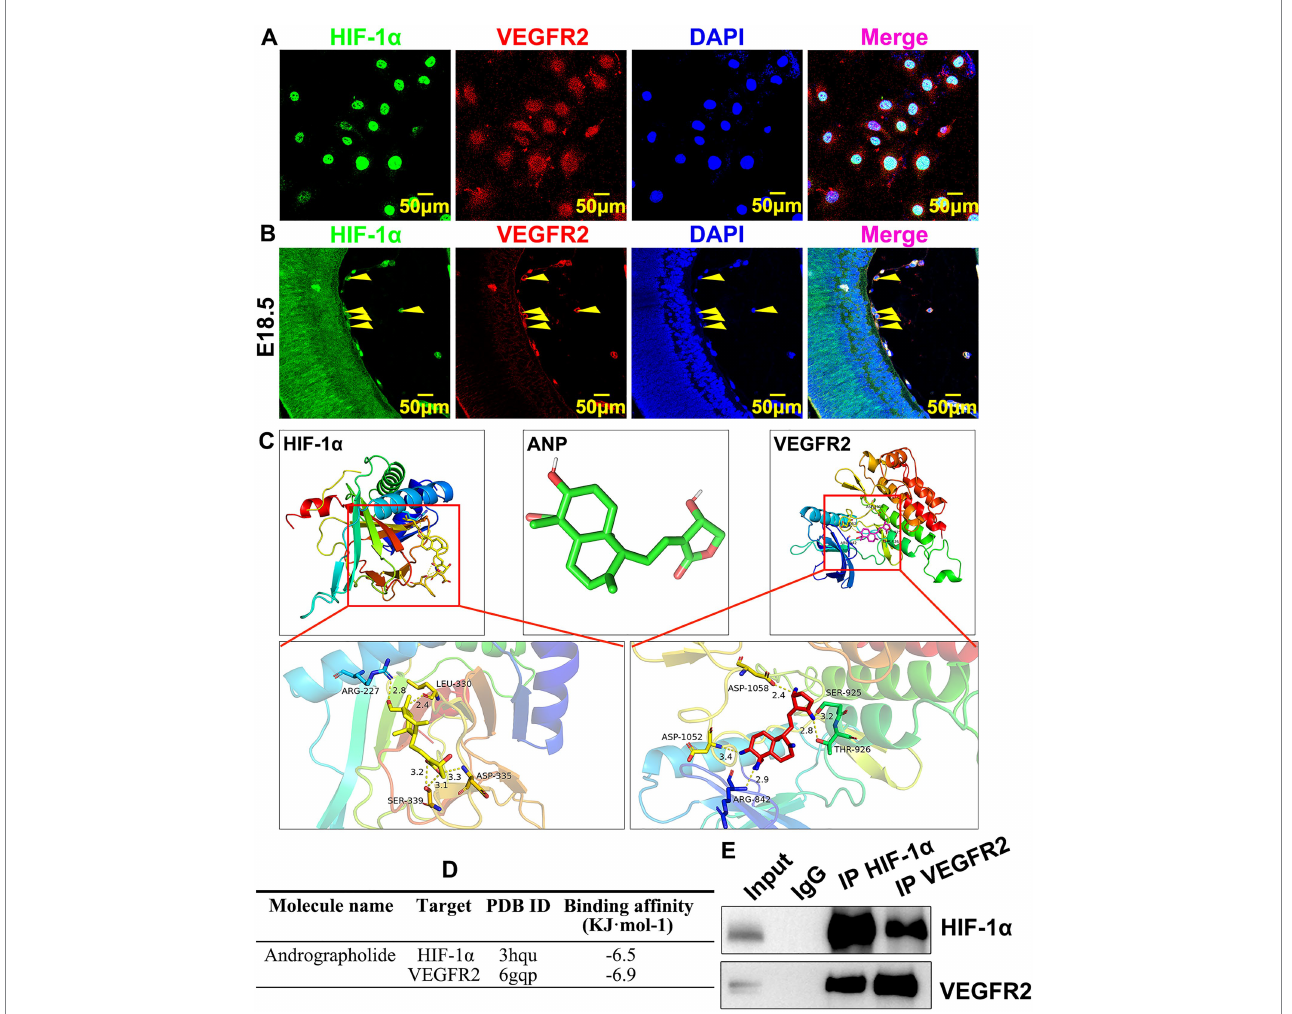
FIGURE 6 Andrographolide potentially interacts with HIF-1a and VEGFR2 in embryonic hyaloid vascular endothelial cells. (A) Hypoxia conditions were induced by 200 μ M CoCl 2 treatment. Immunofluorescence staining against HIF-1a and VEGFR2 antibodies was used to validate co-localization expression of HIF-1a and VEGFR2 in HUVEC-C. (B) Immunofluorescence staining against HIF-1a and VEGFR2 antibodies was used to validate co-localization expression of